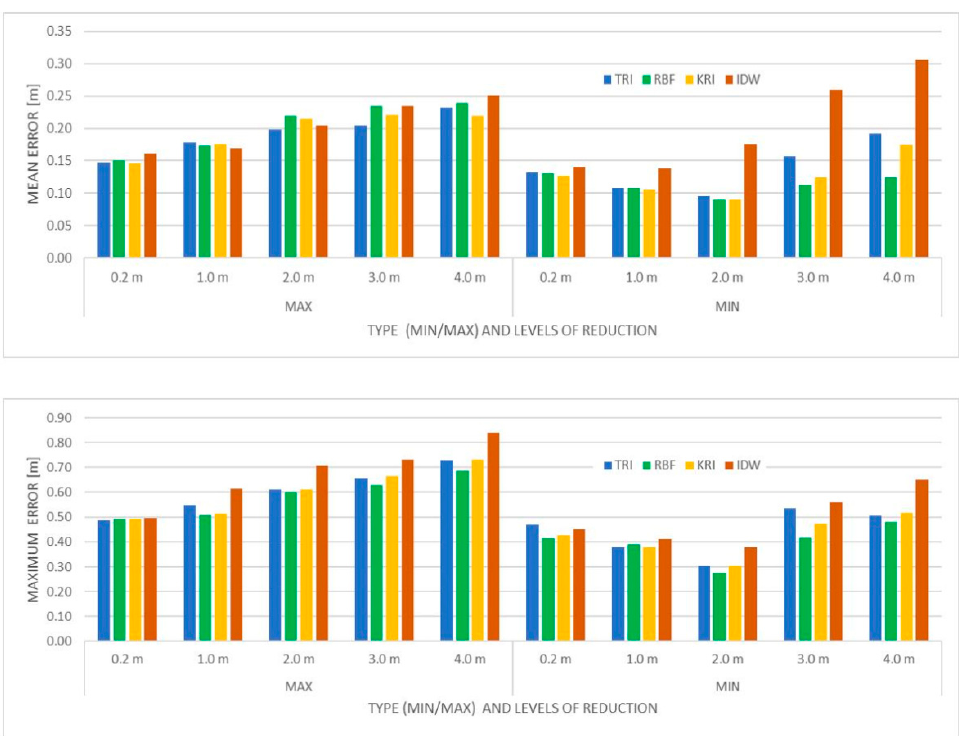
Figure 9. Summary of mean and maximum errors for SBES.